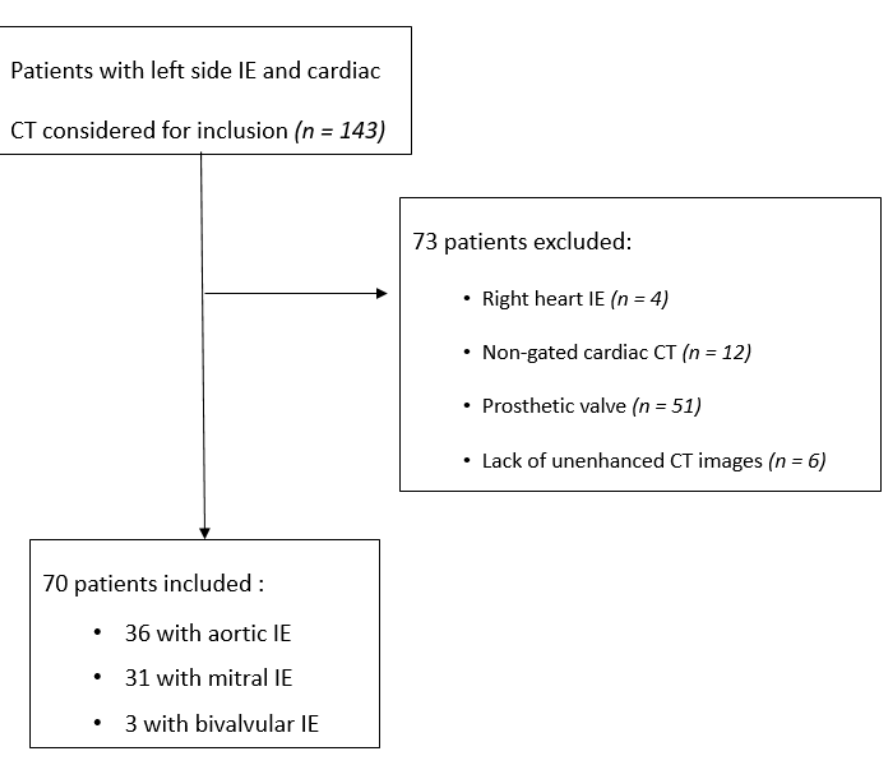
Figure 1. Flowchart of the patients.